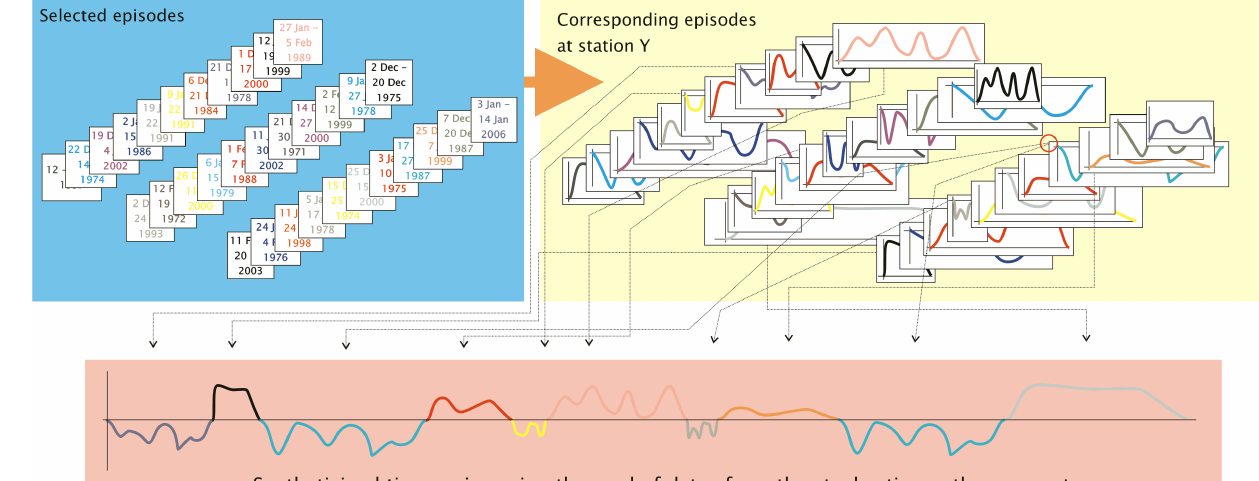
Figure 9. Sketch of the context in which WETTREG applies the WG. Using the pool of dates ( cf. Figure 5), specific episodes are selected and their sequence are prescribed by way of a criteria-driven rejection/acceptance process: the WG (top left panel). This prescription is then applied to identify the corresponding pieces from a time series of an example station Y (top right panel). Finally, for this and each other station, time series are generated in the prescribed sequence (bottom